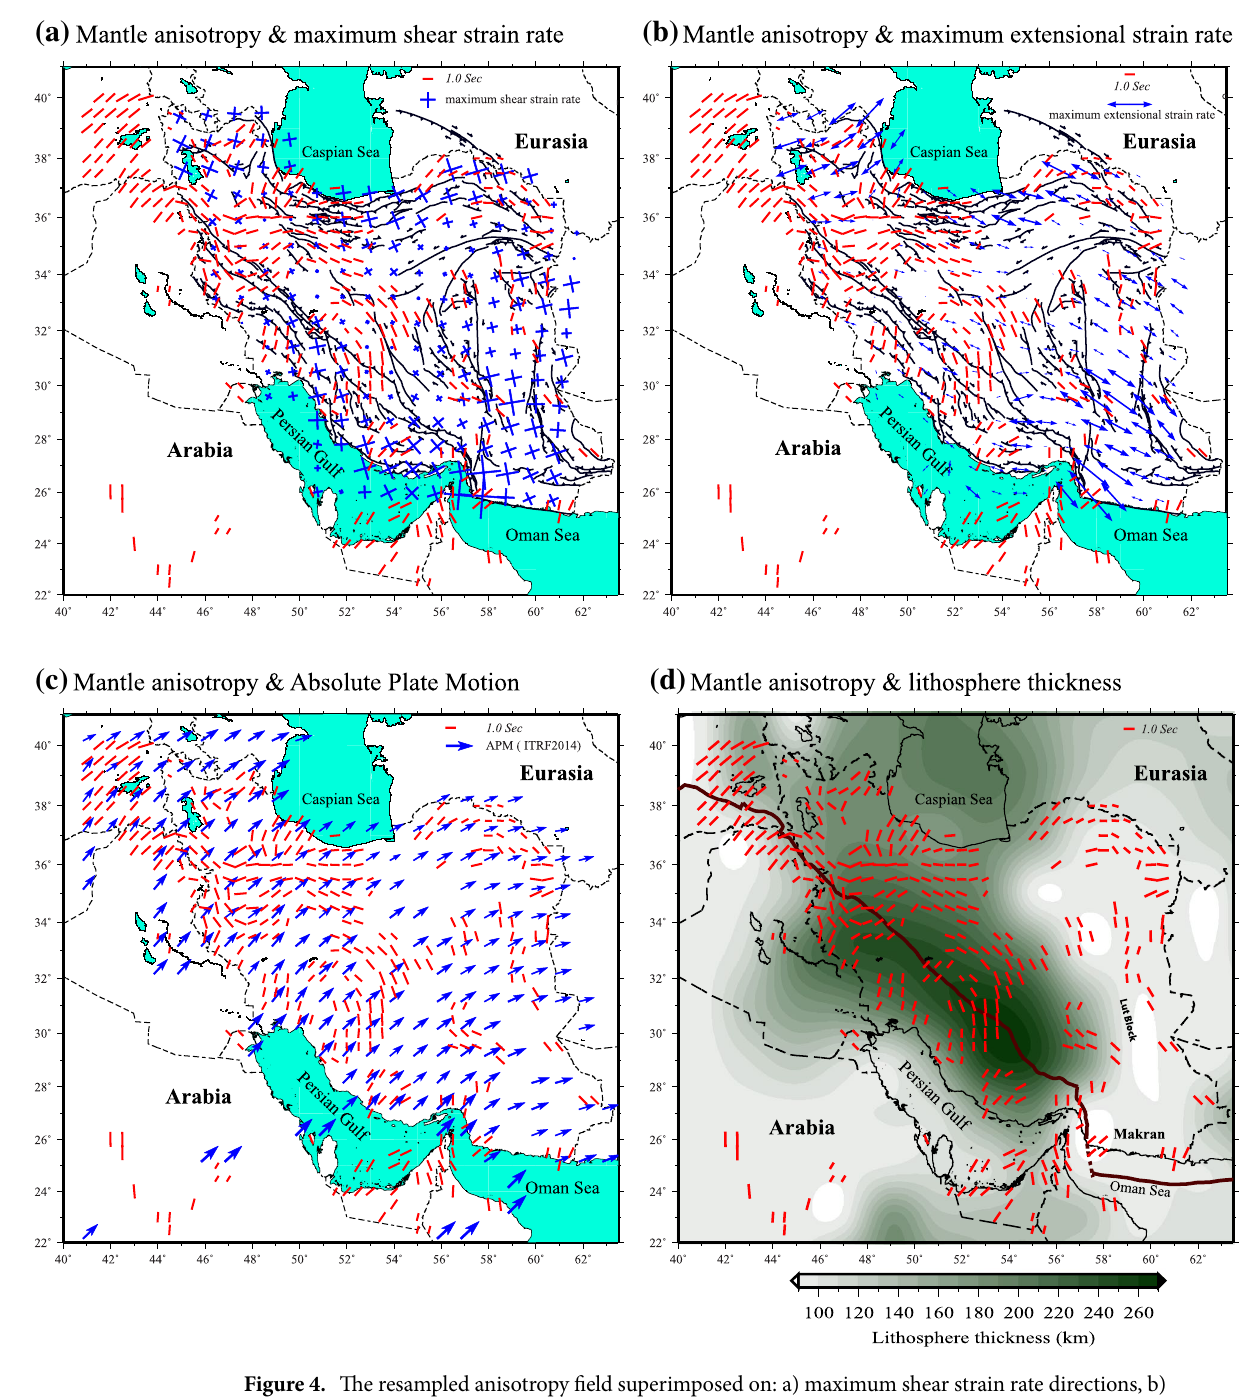
Figure 4. The resampled anisotropy field superimposed on: a) maximum shear strain rate directions, b) maximum extensional strain rate directions, c) the absolute plate motion in the ITRF2014 reference frame 20 (blue arrows), and d) the lithospheric thickness contour map (from Priestley and McKenzie 5 ). GPS velocities and geodetic strain rates are from Khorrami et al 19 . Maps are generated using the GMT 60